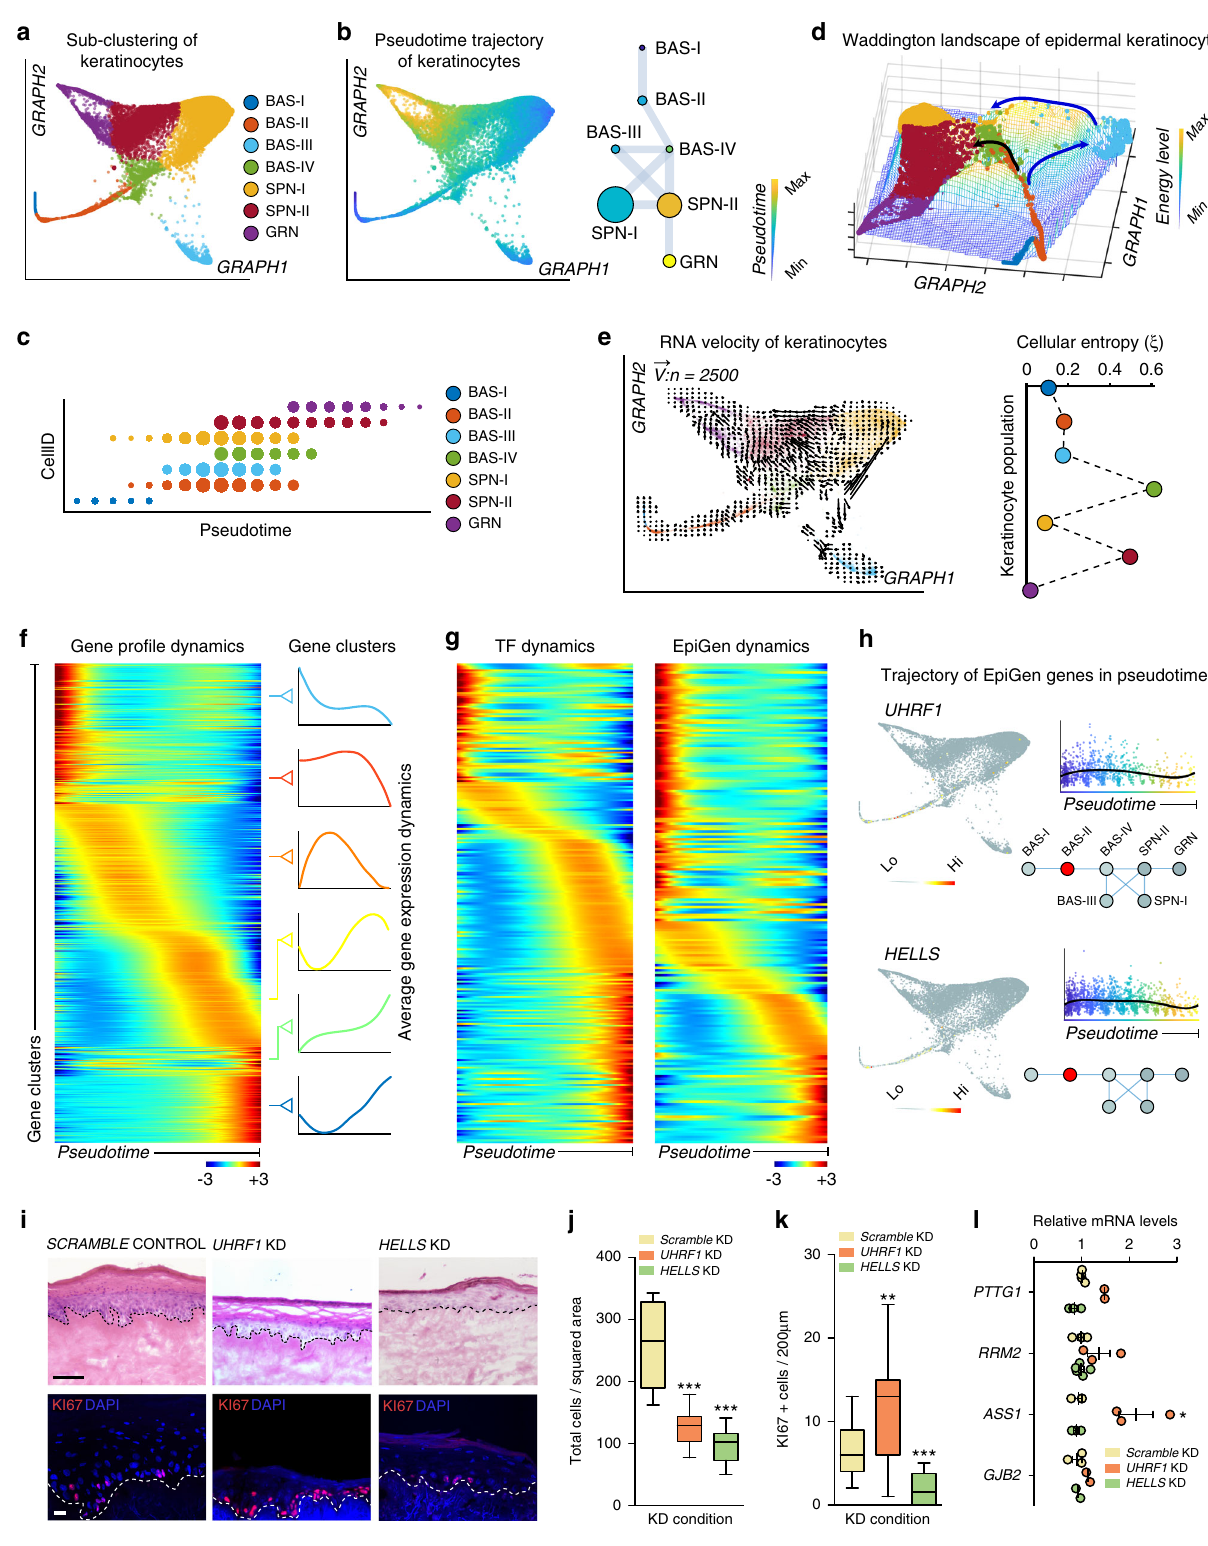
“ valley ” represents a region of low Cellular Entropy (i.e., low likelihood of transition into a new state) and a “ mountain ” represents a region of high Cellular Entropy (i.e., high likelihood of transition into a new state) (Fig. 4d). Two transition trajectories emerge that recapitulates the bifurcation in the differentiation trajectory in Fig. 4b, suggesting that BAS-III and